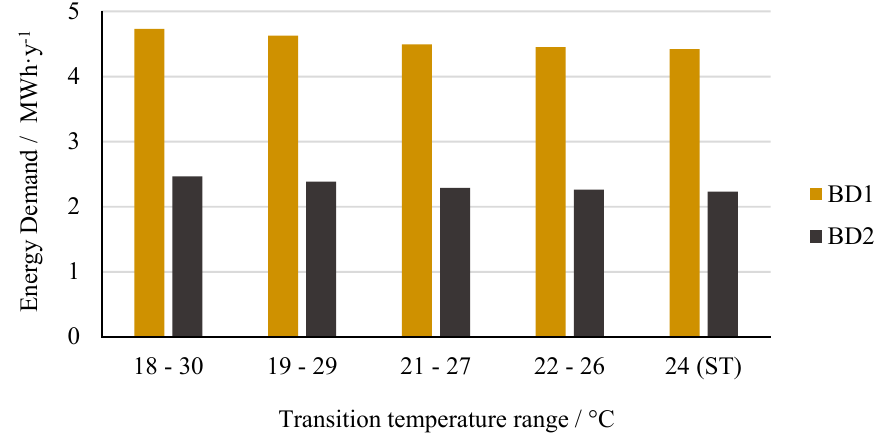
Figure 4. Annual final energy demand for building configurations BD1 and BD2 located in Porto, Portugal, considering different transition temperature ranges.